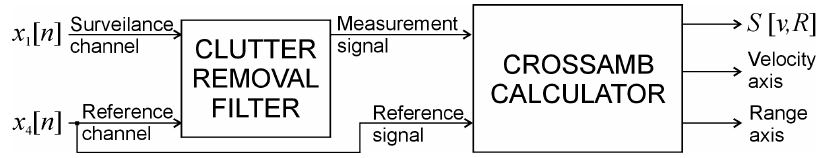
Figure 7. Simplified block diagram of the PCL (passive coherent location) processing algorithm.